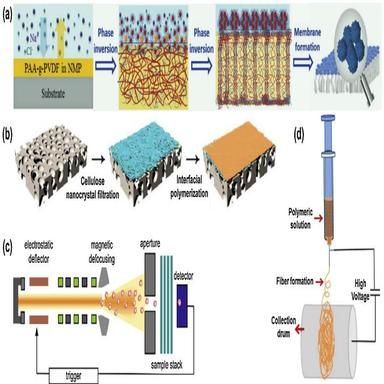
Methods of membrane fabrication: (a) phase inversion process; (b) interfacial polymerization methodology(c) track-etching method and (d) electrospinning process.